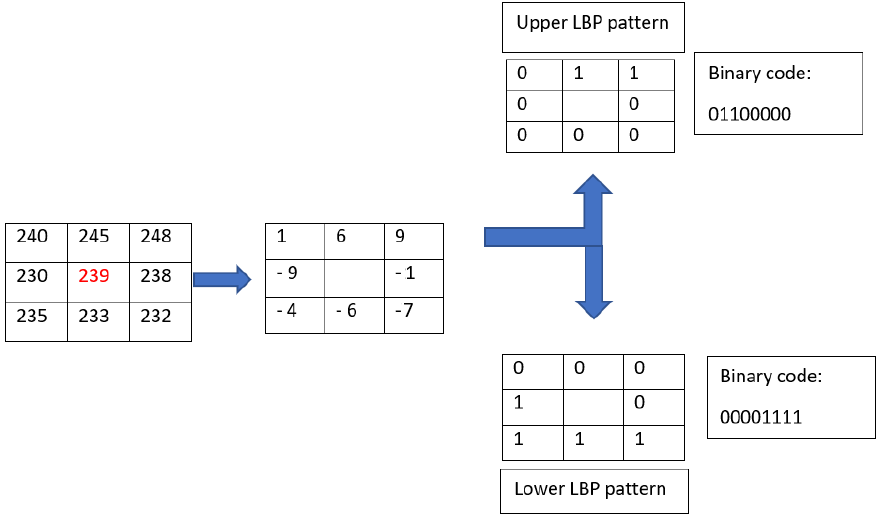
Figure 6. Example of LTP code splitting with threshold t = 3.